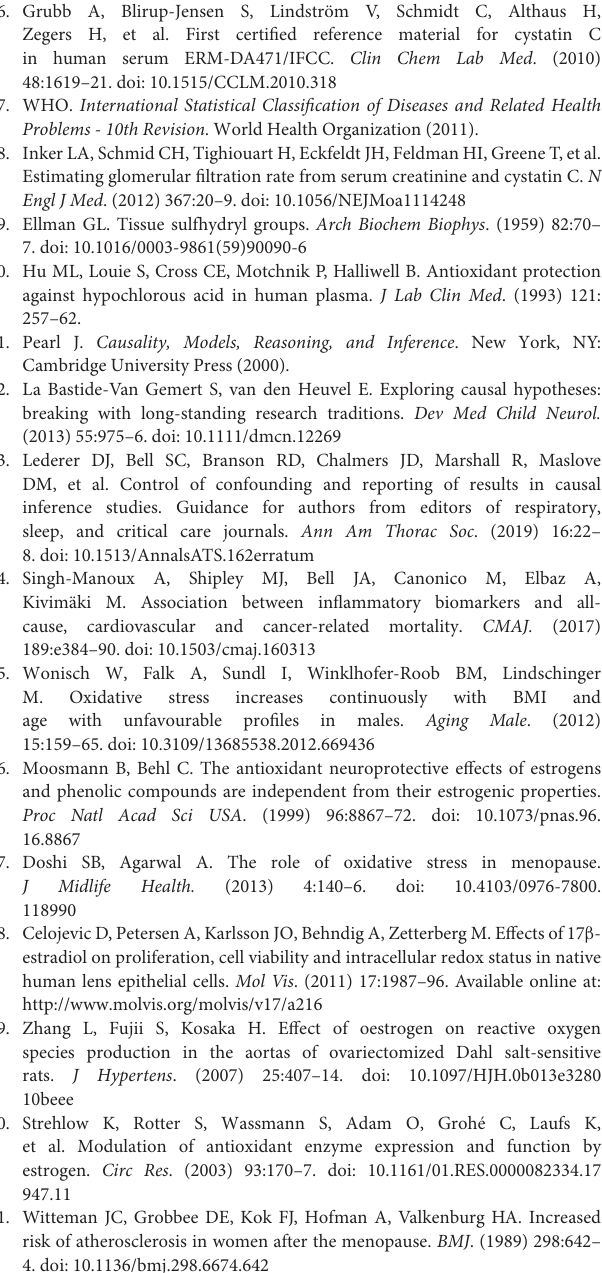
Supplementary Figure 2 | (A–D) Serum free thiols show significant associations with (A) systolic blood pressure, (B) high-sensitive C-reactive protein (hs-CRP), and (C) estimated glomerular filtration rate (eGFR) in premenopausal females. (D) Premenopausal females having diabetes mellitus show significantly lower levels of serum free thiols ( ∗∗∗ P < 0.001). Supplementary Figure 3 | (A–D) In postmenopausal females, serum free thiols showed significant inverse associations with (A) age and (B) body mass index (BMI), whereas positive associations were observed for (C) estimated glomerular filtration rate (eGFR) and (D) hemoglobin